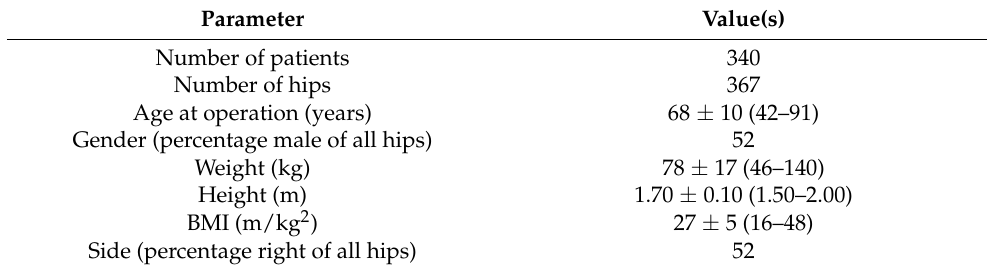
Figure 2. Flow chart of included hips. Table 1. Demographic and surgery related data.